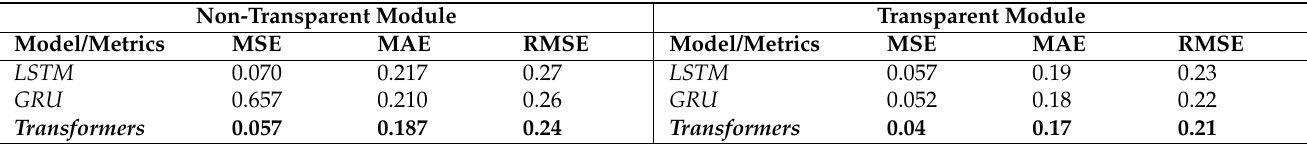
Table 2. Evaluation metric results for Non-Transparent and Transparent